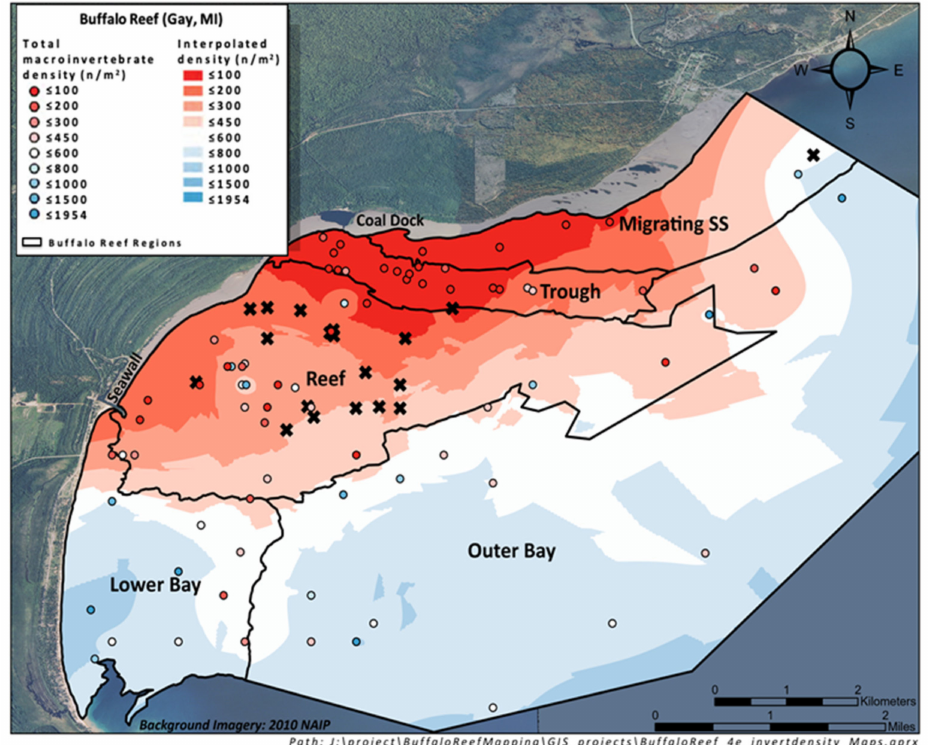
Figure 14. Density of macroinvertebrates contoured by kriging techniques across Grand (Big) Tra- verse Bay. Lowest densities are in deep red (Legend in upper left). Notice that densities are impacted most in high stamp sand and Cu-rich regions off the shoreline and less in the Lower Bay and deeper Outer Bay